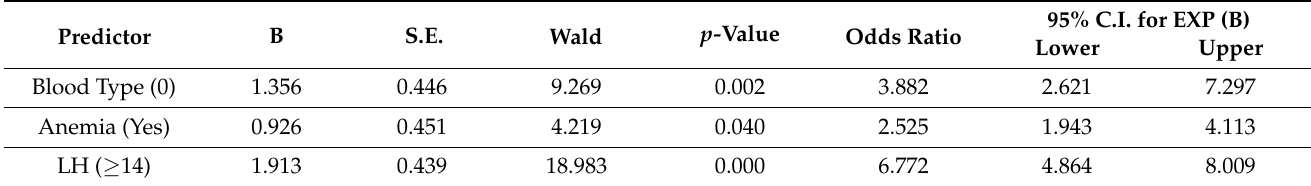
Table 4. Multivariate analysis of the risk of NI